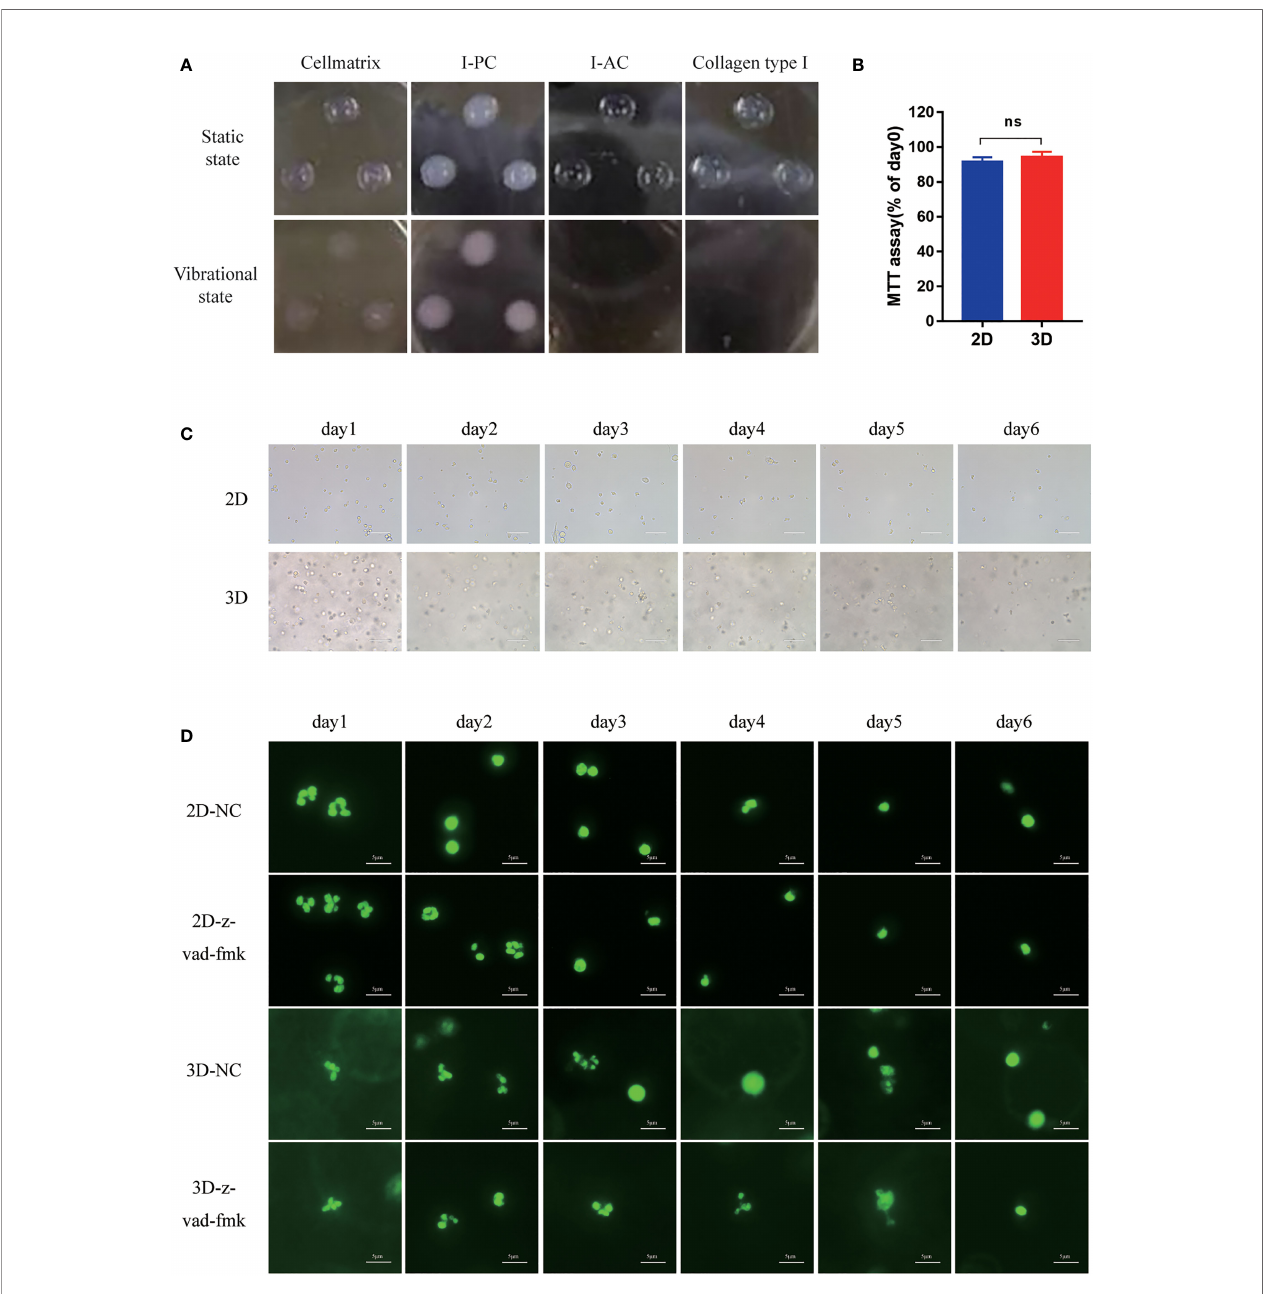
FIGURE 2 | The morphology of Neu in 2D and 3D culture systems. (A) Morphology of Cellmatrix Type I, I-PC collagen and I-AC and Collagen type I in a static state or vibrational under light microscope. (B) Toxicity testing was evaluated by the MTT assay. Mouse bone marrow-derived Neu were embedded in Cellmatrix Type I and cultured for 24 h. MTT reagent was used to detect the survival rate of the cells. (C) The morphology of mouse peripheral blood Neu representative light microscopy photographs (600x). (D) Representative fl uorescence micrograph of human peripheral blood Neu dyed by SYTO 13 (stain DNA in both live and dead eukaryotic cells) during 6 days in 2D and 3D culture systems with or without the inhibition of apoptosis z-vad-fmk. Error bars represent mean ± S.D. n = 3, ns, not statistically signi fi cantly different by One-way